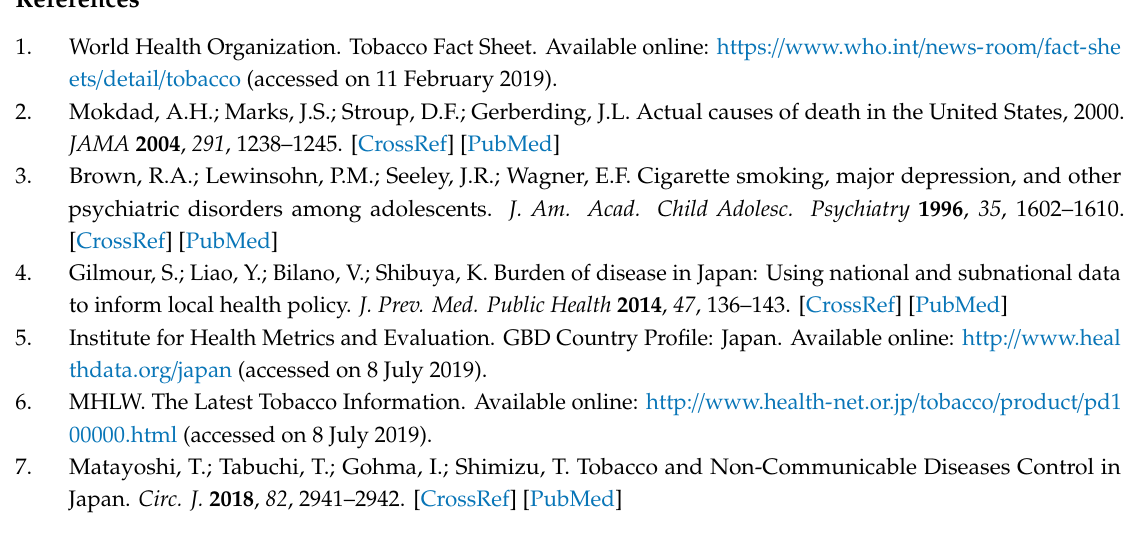
Supplementary file 1: The list of questions from the survey questionnaire; Supplementary file 2: The risk of exclusive alternative product use compared with exclusive cigarette use among any product